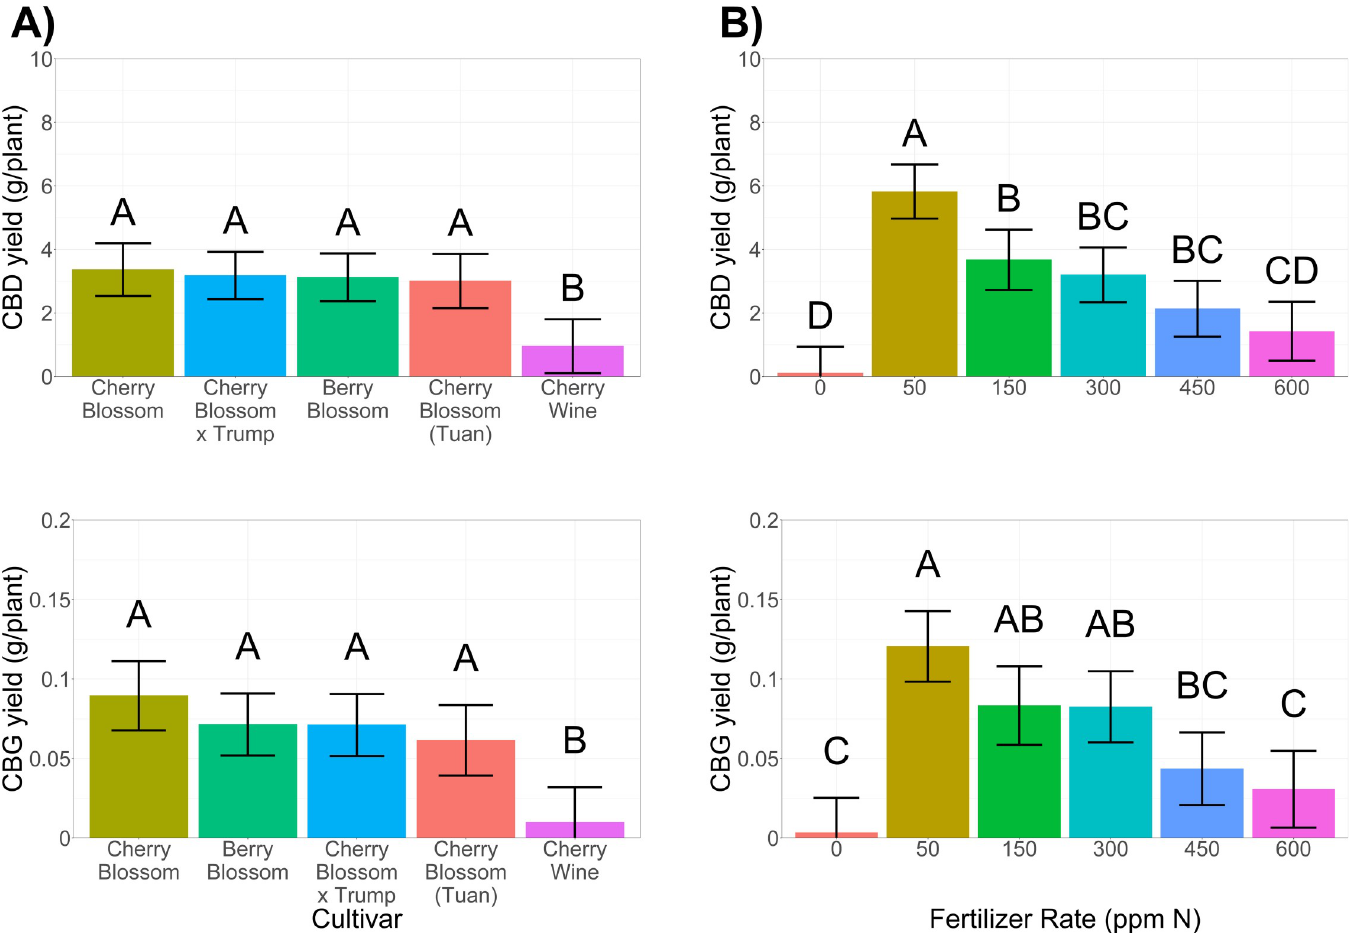
Fig 6. Cannabidiol (CBD; top row) and canabigerol (CBG; bottom row) across [A] cultivars and [B] fertilizer rates. Error bars depict 95% confidence intervals and connecting letters indicate statistical differences using Tukey’s HSD ( α = 0.05).